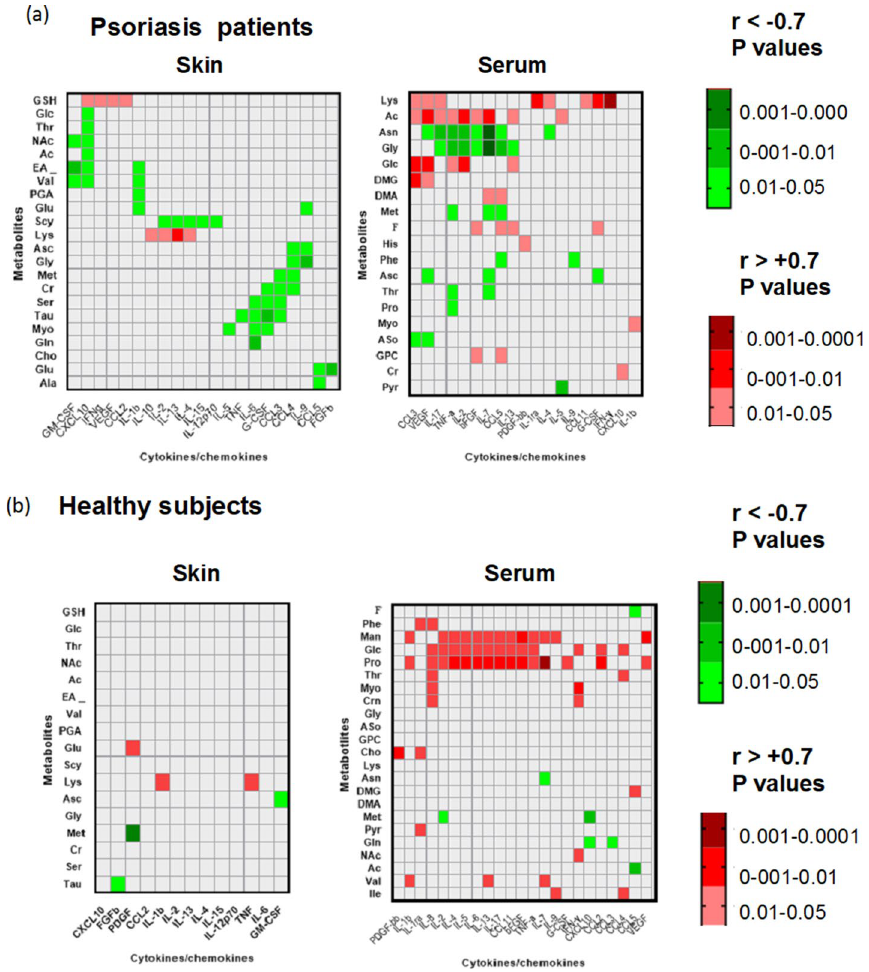
Figure 4. Heat maps of significant correlations between metabolites and cytokines/chemokines analyzed in skin biopsies and serum samples from psoriasis patients ( a ) or healthy control subjects ( b ). Pearson correlation coefficients (r) were used to express the correlation and r values < − 0.7 and > + 0.7 were selected to indicate negative and positive correlations, respectively. Green color gradients indicate negative correlations with values < 0.05 and red color gradient indicates positive correlations with p values < 0.05. r values not reaching significance correspond to uncolored squares. The complete table of r and p values of the correlations in the tissues analyzed is reported in supplemental data as supplementary table. Figure produced by Prism Software, version 8.3.0 Inc. USA (https:// www. graph pad. com/). No permission